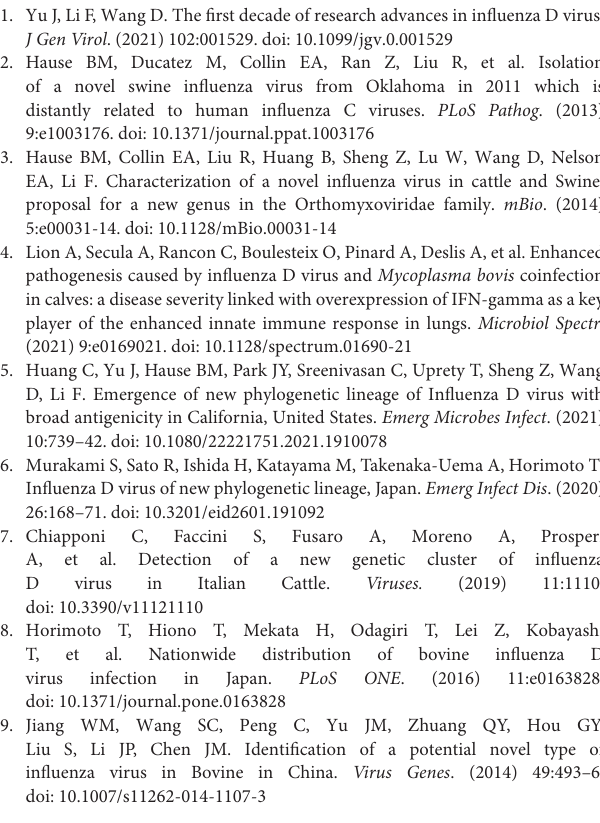
Supplementary Figure S1 | Sequence aligment of partial P42 gene amplicons of IDV-positive samples. The partial P42 gene sequences for IDV-positive samples ZS29-31, ZX56-58, ZS118-120, ZS130-132, ZS133-135, ZS16-18, and ZS63-65 were obtained by Sanger sequencing, and aligned together with the corresponding sequences of representative strains of the D/OK lineage, D/660 lineage, D/Yama2016 lineage, D/Yama2019 lineage, D/CA2019 lineage and D/China sub-lineage. The partial P42 gene sequences for IDV-positive samples ZS29-31, ZS130-132, ZS133-135, and ZS16-18 are identical to the corresponding sequence of D/swine/Oklahoma/1334/2011, the partial P42 gene sequences for IDV-positive samples ZX56-58 and ZS63-65 are close to